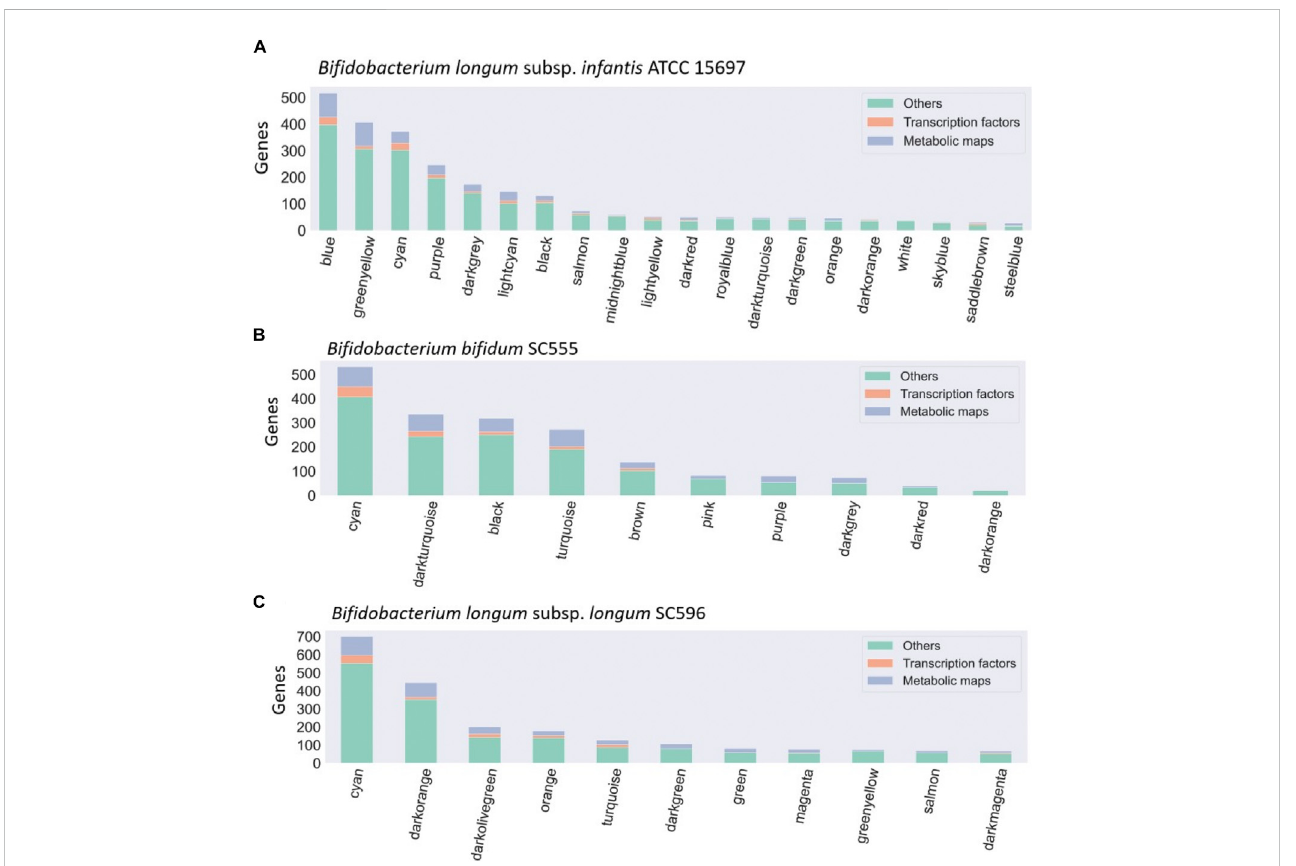
FIGURE 3 Bacteriaco-expressionmodulesin (A) B. infantis ATCC15697, (B) B.bi fi dum SC55,and (C) B. longum subsp. longum SC596.Onthex-axisareshownthe modules identi fi ed with the WGCNA package, identi fi ed with a number. The distribution of modules is represented in decreasing order, where the y-axis represents the number of genes per module. Each module is made up of a set of genes associated with TFs (orange), metabolic maps (blue), and others unclassi fi ed genes